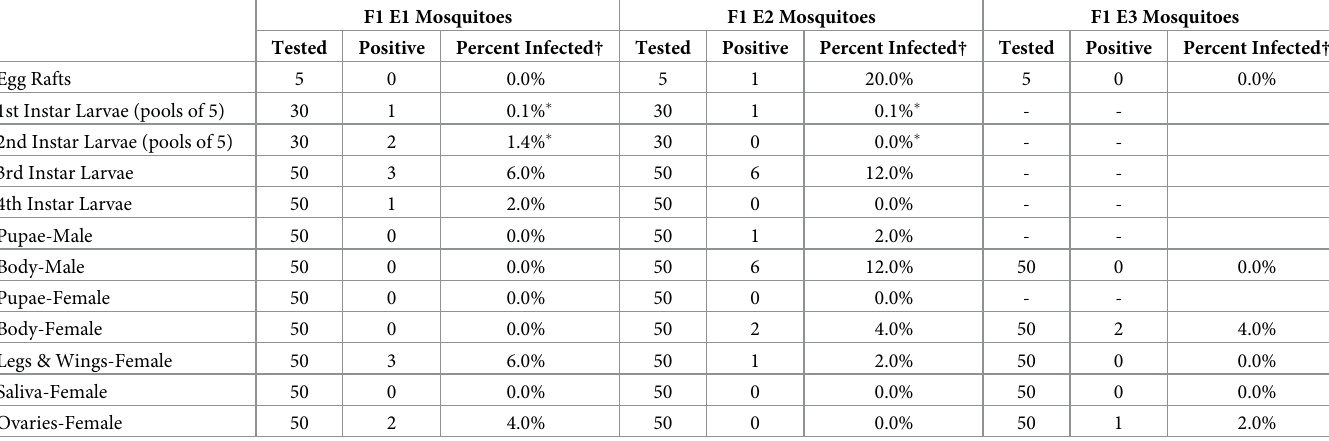
Table 3. Percent of tissues testing positive for RVFV via plaque assay among progeny mosquitoes.